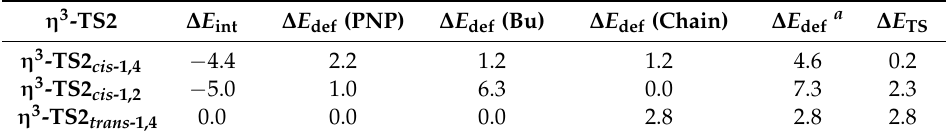
Table 3. Energy decomposition analysis (kcal/mol) of the transition states for the second monomer insertion into P1 cis . The relative interaction energies and decomposition energies are given in kcal/mol. η 3 -TS2 ∆ E int ∆ E def (PNP) ∆ E def (Bu) ∆ E def (Chain) ∆ E def a ∆ E TS η 3 -TS2 cis -1,4 η 3 -TS2 cis